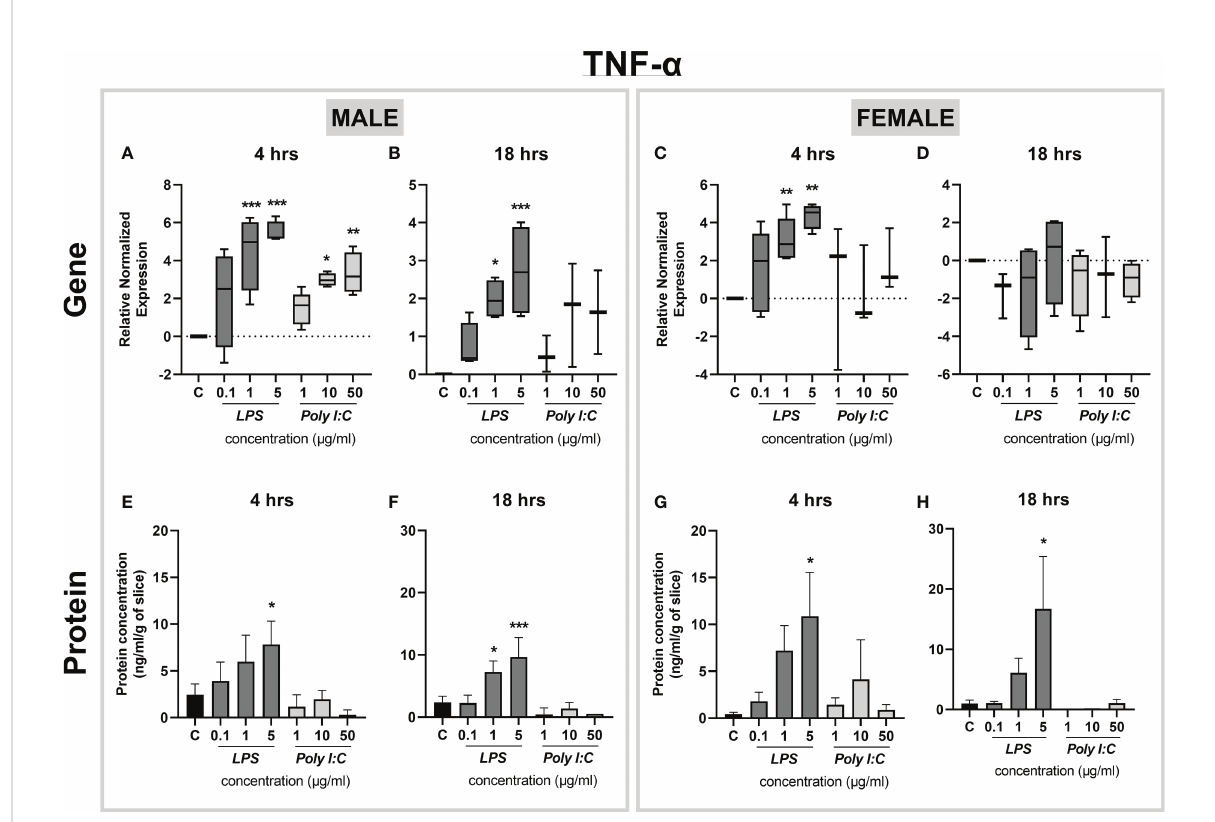
FIGURE 3 Effect of LPS and Poly I:C on TNF- a gene expression and protein concentration. Male and female placental slices were exposed to LPS and Poly I:C at various concentrations for 4 and 18 hours. Gene expression of Tnf- a in placental slices was evaluated by qPCR analysis (A-D) . TNF- a protein concentrations were measured in culture media using a commercially available ELISA kit (E-H) . Data are shown as Tukey boxplots or mean ± SEM; n ≥ 3. *P < 0.05; **P < 0.01; ***P <